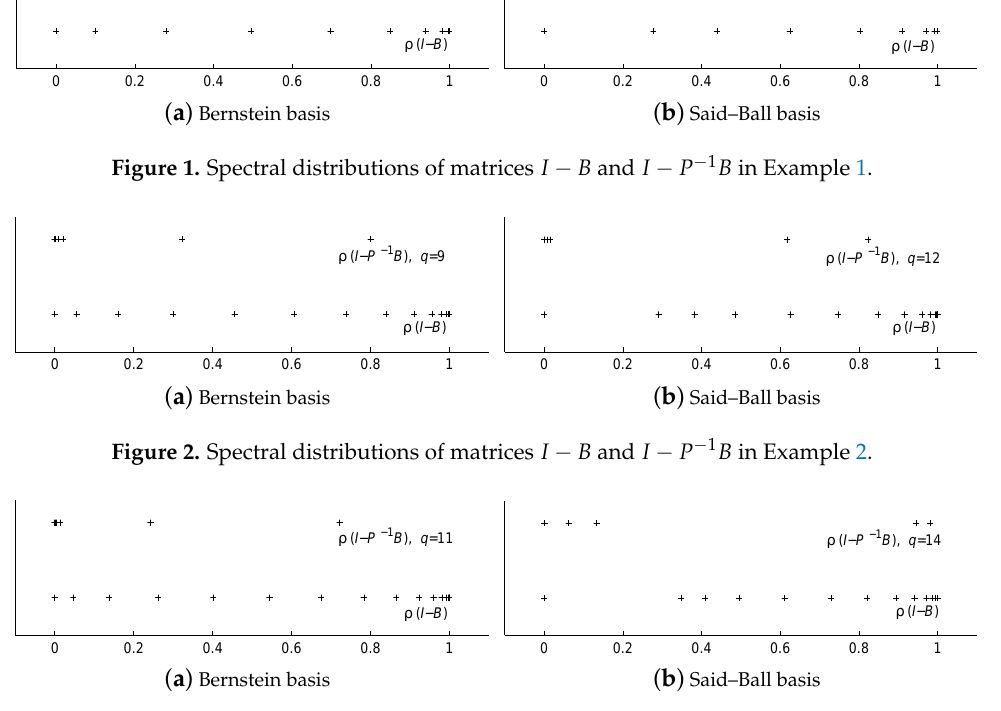
Figure 3. Spectral distributions of matrices I − B and I − P − 1 B in Example